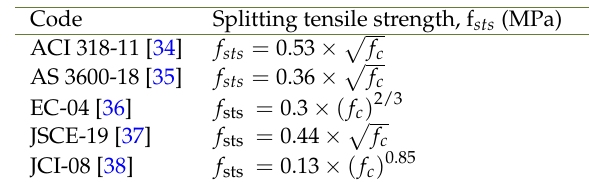
Table 3. Summary of the code expressions for prediction of the splitting tensile strength of concrete.